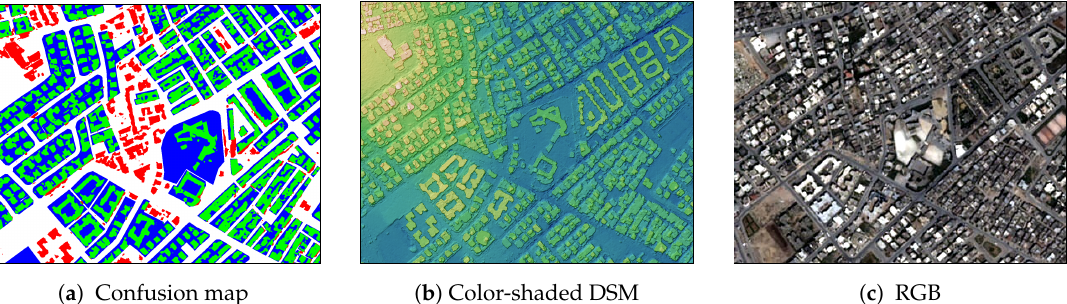
Figure 13. Comparison of OSM data and a footprint mask generated by the proposed Hybrid-PS-Unet model with pansharpening fusion. In ( a ), at locations with green pixels, both OSM and our model predict building. At white pixels, our architecture and the OSM data predict non-building. At locations with red pixels, our architecture predicts building and the OSM data predicts non-building. At pixels with blue colours, the OSM data predicts building and our model predicts